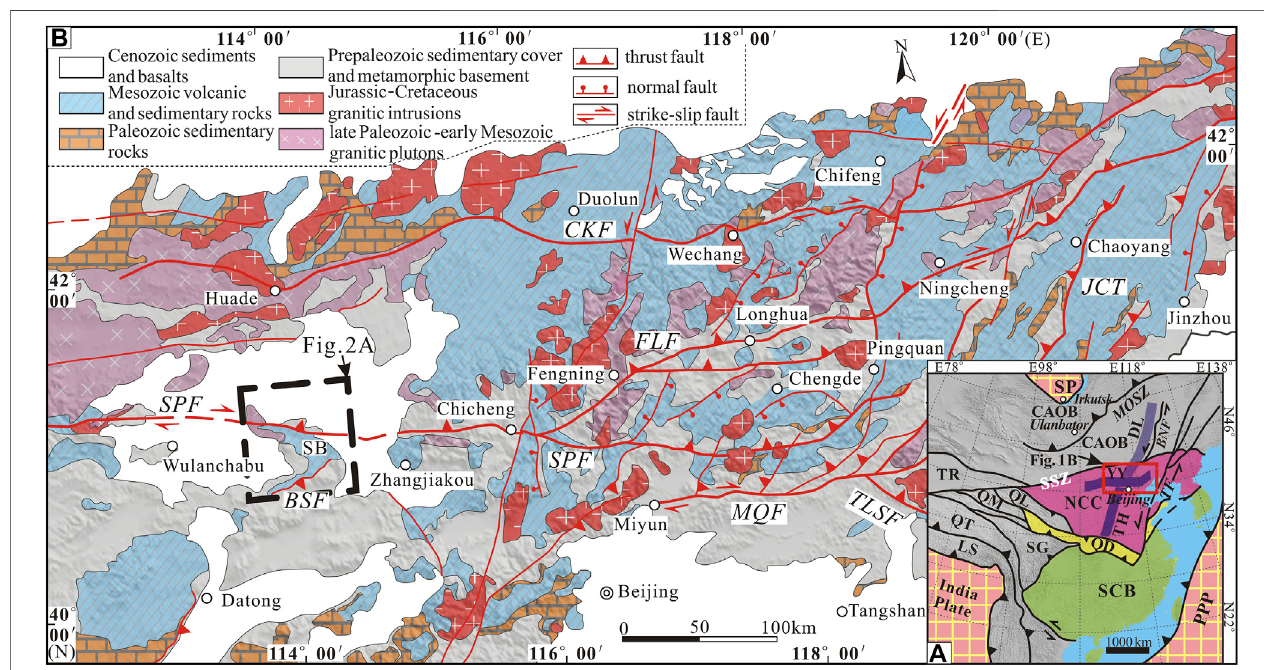
FIGURE 1 |(A) Structural outline of the North China Craton and the surrounding. (B) Geological sketch ofthe northern margin ofthe North China Carton (modi fi ed after Zhang et al., 2006; Zhang et al., 2011). SP, Siberian plate; PPP, Paleo-Paci fi c plate; IP, Indian plate; NCC, North China Craton; SCB, South China block; QM, Qaidam block; TR, Tarim block; QT, Qiangtang terrane; LS, Lhasa terrane; SG, Songpan-Ganzi belt; CAOB, Central Asian Orogenic Belt; MOSZ, Mongol-Okhotsk suture zone; SSZ, Solonker-Linxi suture zone; YY, Yinshan-Yanshan fold-thrust belt; QD, Qinling-Dabie Orogen; QL, Qinlian belt; TH, Taihang Mountains; DL, Dahingganling; TF, Tan-LuFault Zone; BNF, Balihan-Nenjiang Fault Zone; CKF, Chifeng-Kaiyuan Fault; FLF, Fengling-Longhua Fault; JCT, Jianchang-Chaoyang Thrust Fault; SPF, Shangyi-Pingquan Fault; MQF, Miyun-Qinglong Fault; TLSF, Taiying-Lengkou-Shangying Fault; BSF, Banshen-Shuiquangou Fault; SB, Shangyi Basin.